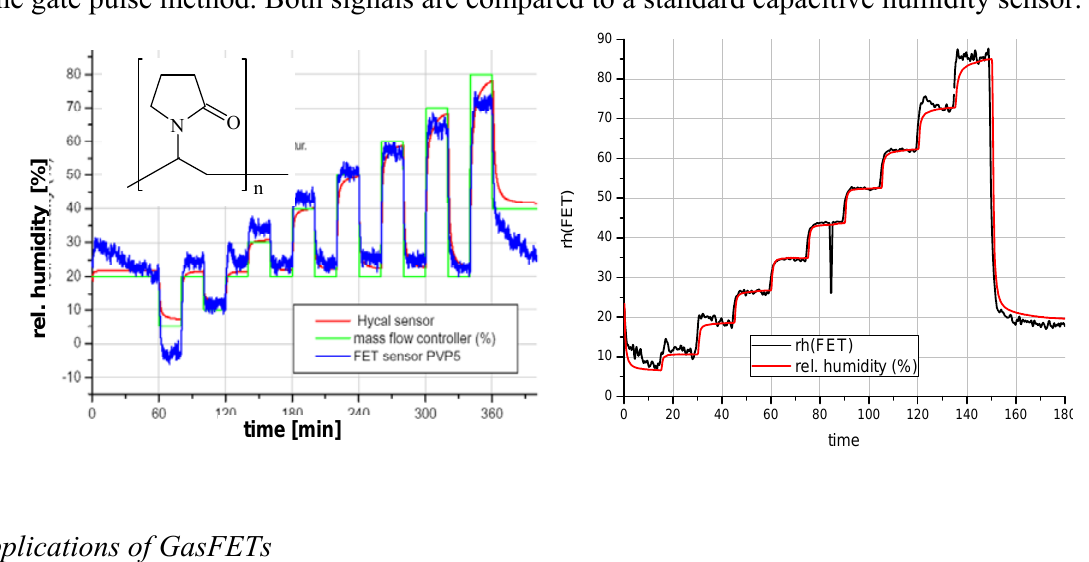
Figure 20. Polymers for humidity detection employed in the GasFET platform. Left: polyvinylpyrrolidone with classical work function readout. Right: polyamide readout by the gate pulse method. Both signals are compared to a standard capacitive humidity